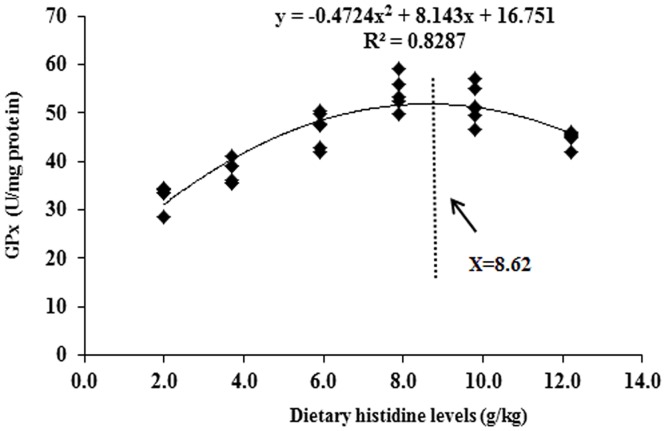
A quadratic regression analysis of the entire intestinal glutathione peroxidase activity for young grass carp fed with diets containing graded levels of histidine for 8 weeks, followed by exposure to 0.7 mg Cu/L water for 4 days.